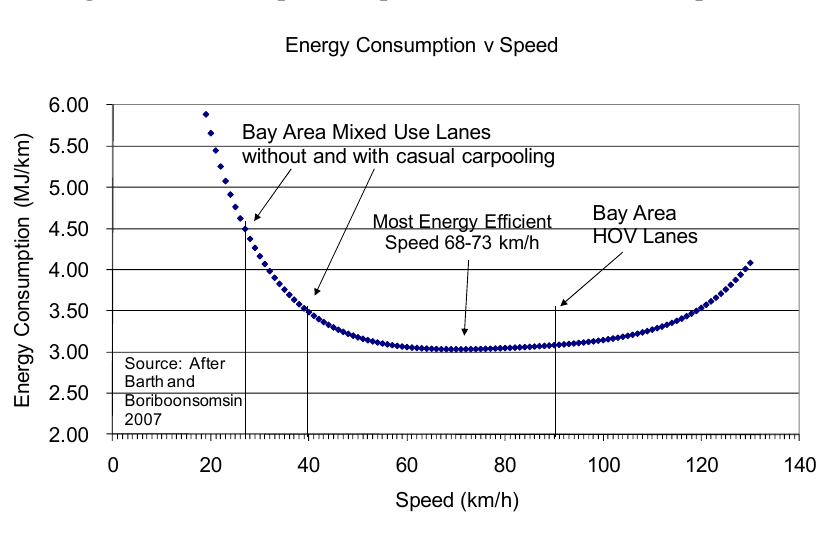
Figure 6. Consumption Impact of Different Traffic